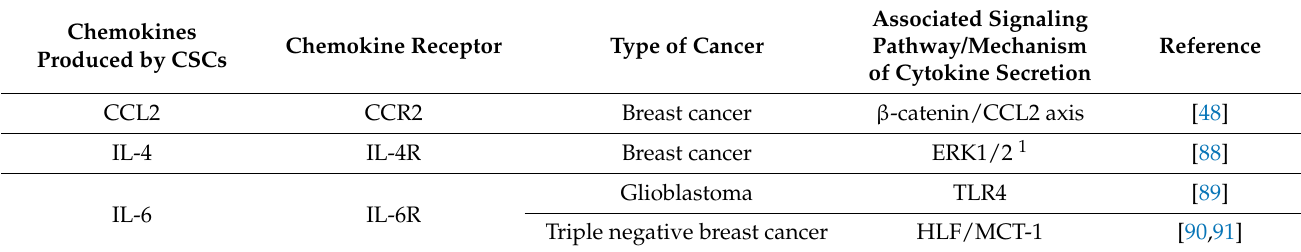
Table 2. CSCs secreted molecules to induce the polarization of